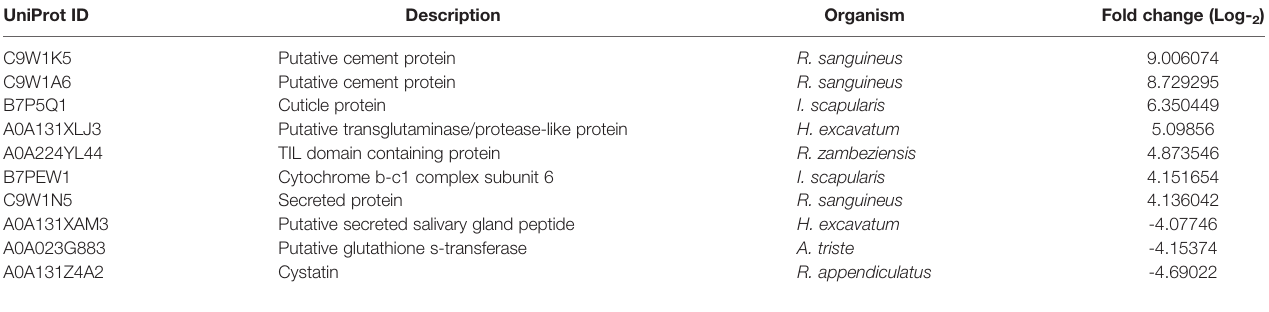
TABLE 1 | Proteins identi fi ed in salivary glands of R. sanguineus from the tropical lineage vs. R. sanguineus from temperate lineage identi fi ed only in the infection condition, with log 2 -normalized fold-change ≤− 4 or ≥ 4.